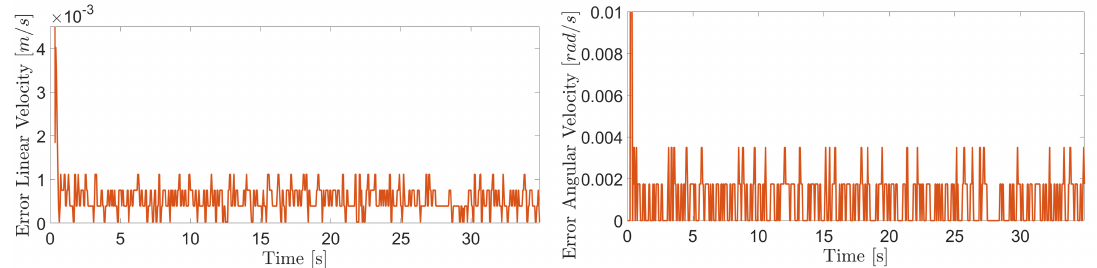
Figure 22. Linear and angular velocity errors during navigation of the climbing robot at 45 degree inclination.